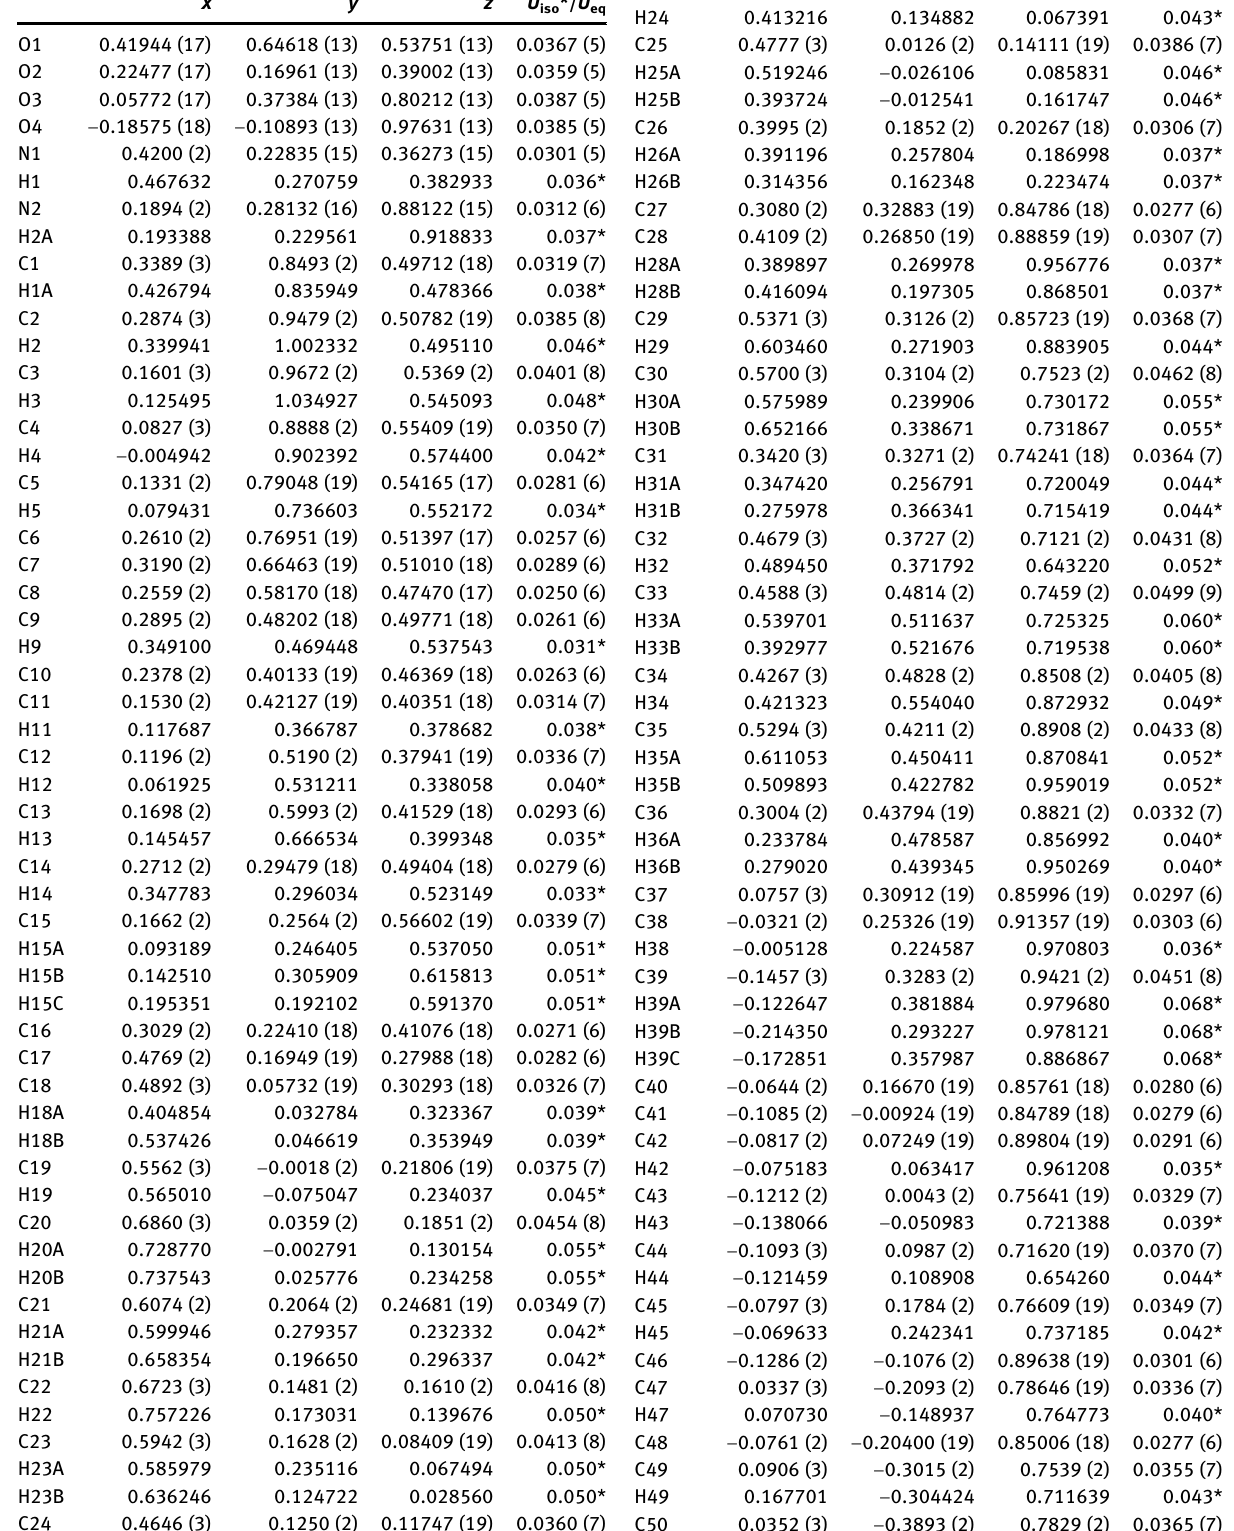
Table  : Fractional atomic coordinates and isotropic or equivalent isotropic displacement parameters (Å 